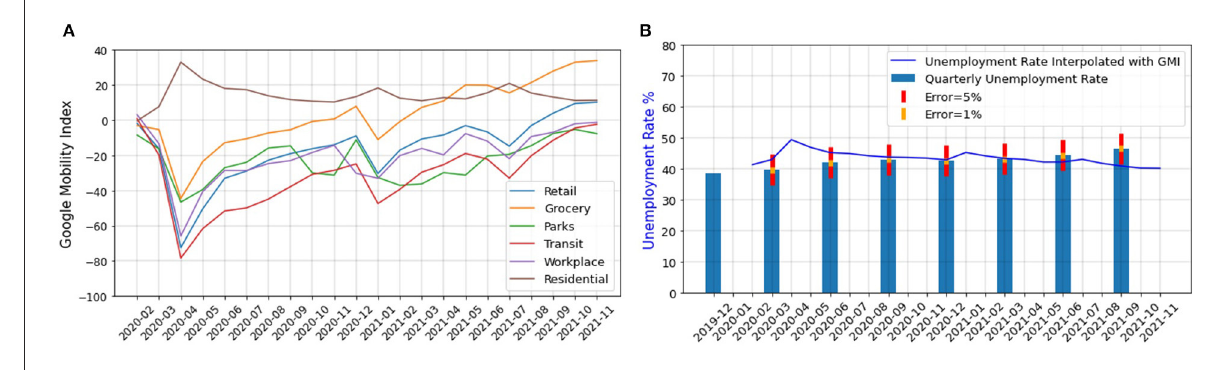
FIGURE2 (A) GMI for different categories of places over time for South Africa (28), (B) Unemployment rate of South Africa interpolated with